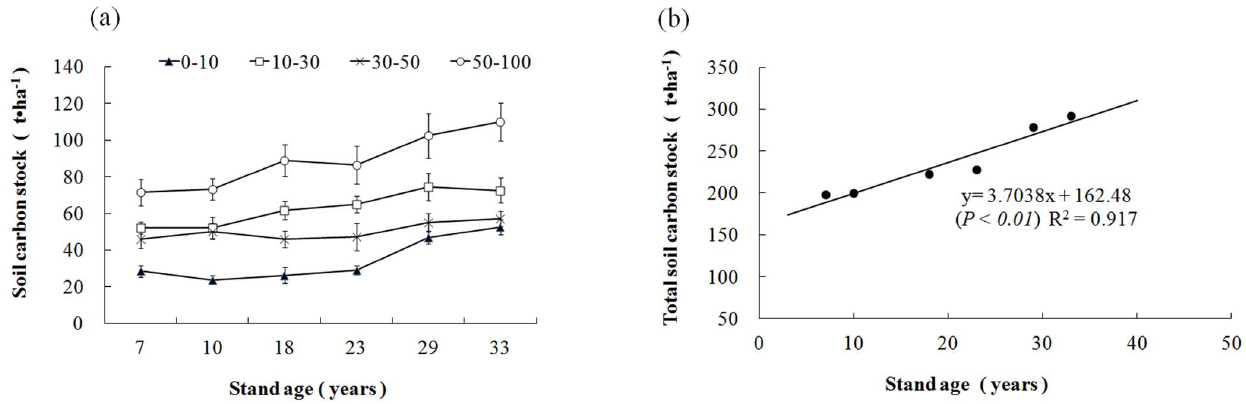
Figure 3. Soil layer carbon stocks in six differently aged Mytilarialaosensis stands (a) and the linear relationship between soil carbon stocks and stand age (b). Values are means 6 SE n=12. Soil depth ranges in the key to (a) are in cm units.